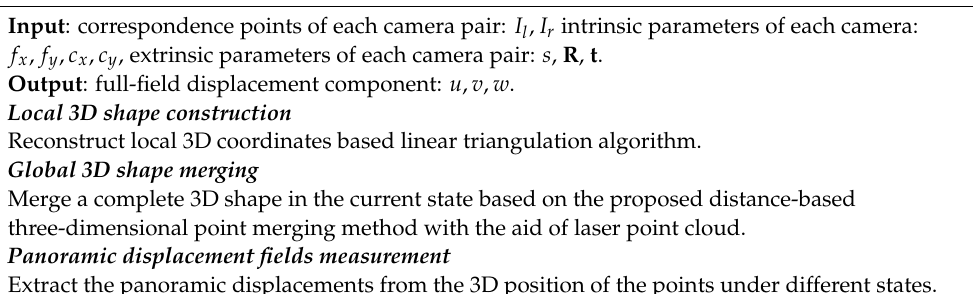
Algorithm 4 Determining full-field displacements from three-dimensional shape